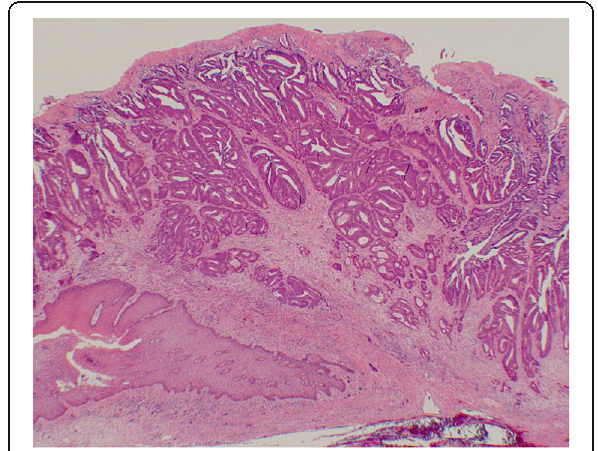
Fig. 2 Colonoscopy image of an anal tumor. The tumor was a 1.0- cm irregular mass, displayed redness on the anal skin, and biopsy revealed the same histology as that of the rectal carcinoma